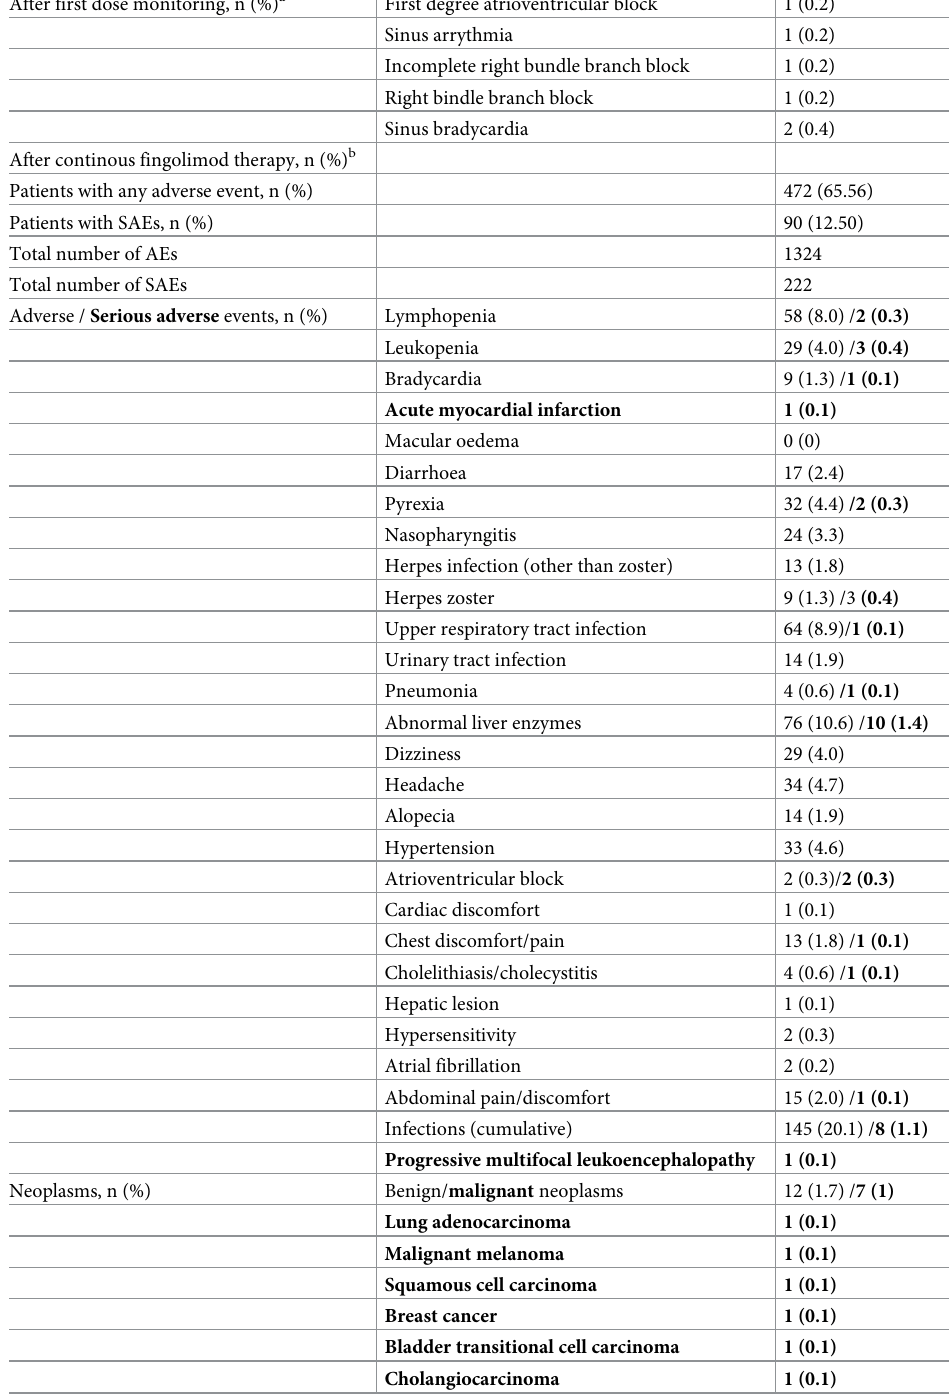
Table 4. Adverse events and serious adverse events of special interest during the follow-up